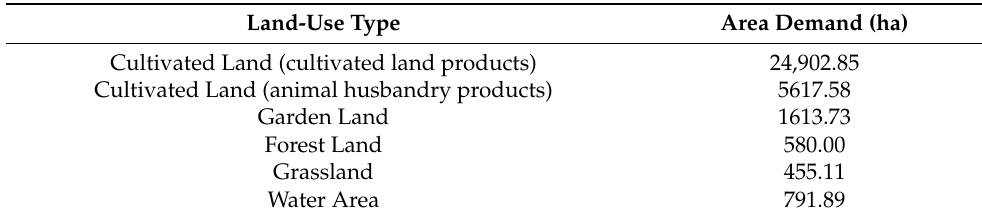
Table 7. Area demands for cultivated land, garden land, forest land, grassland, and water to realize population